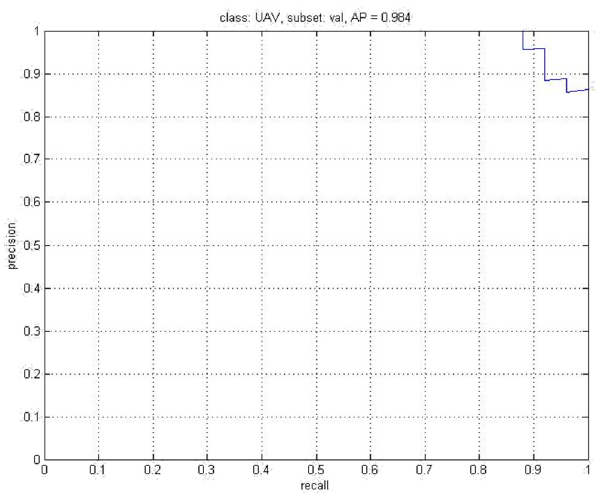
Figure 12. AP of Faster R-CNN.